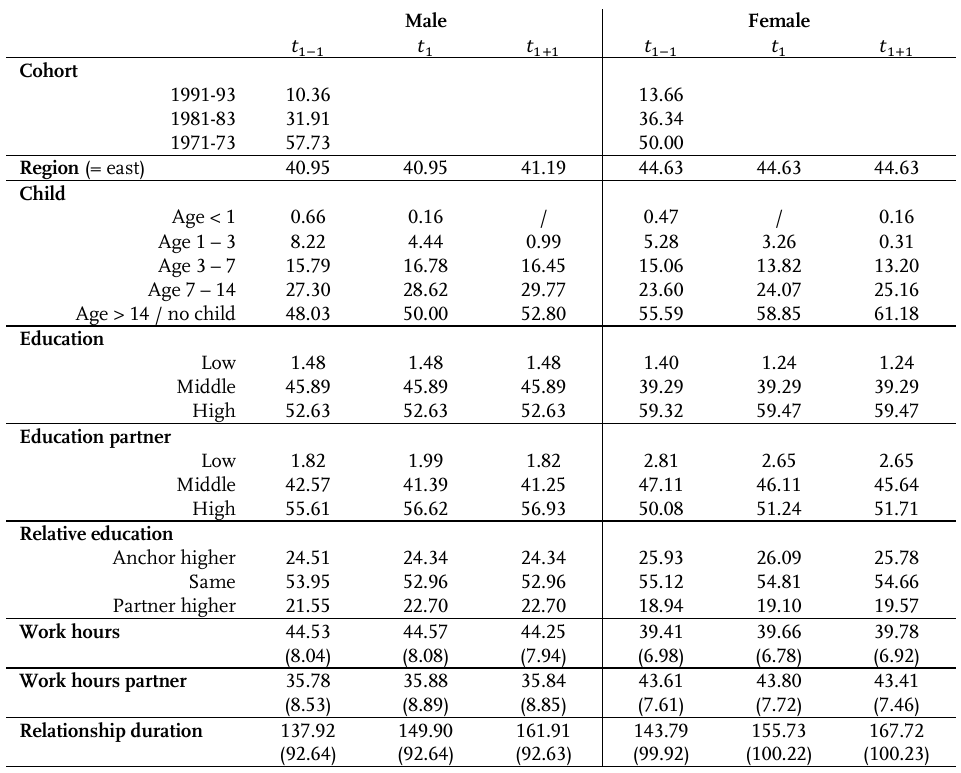
Table 1 : Sample descriptives in percentages and mean values divided by men (n = 608) and women (n =